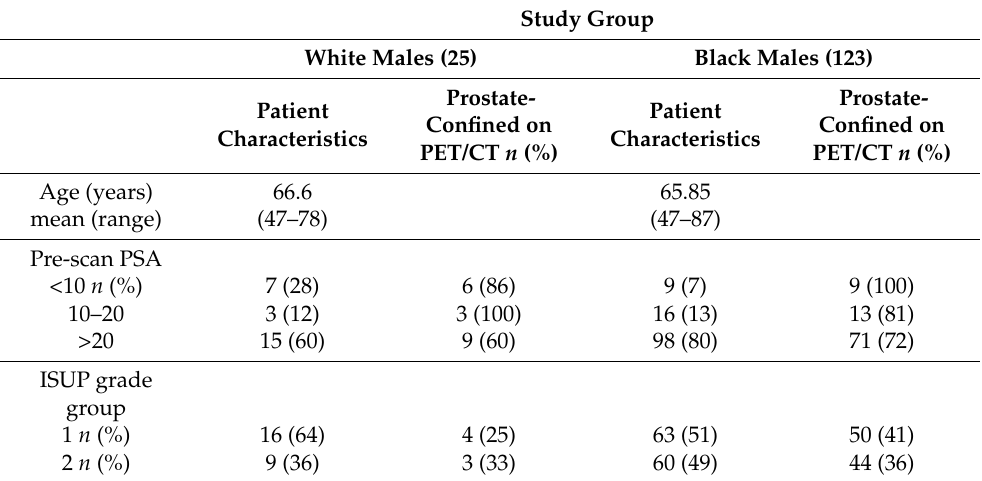
Table 1. Patient